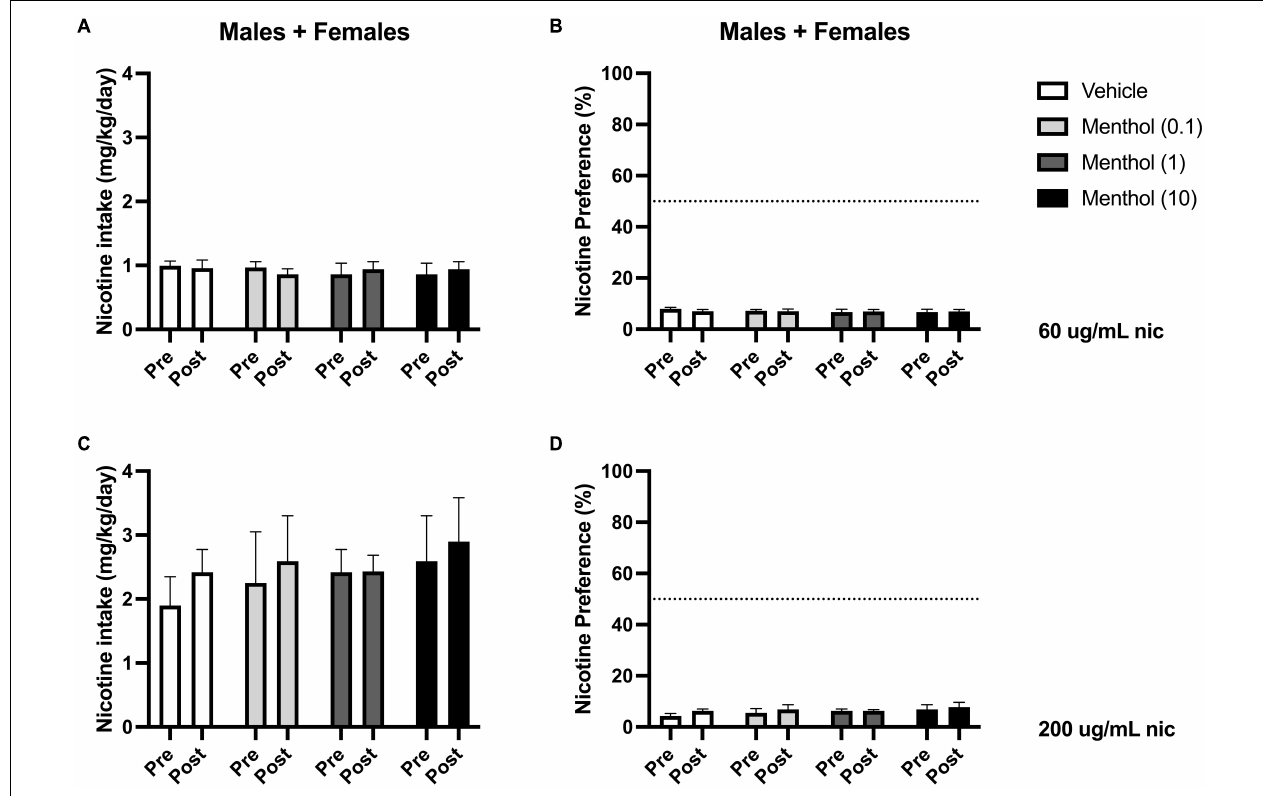
FIGURE 5 | Impact of systemic administration of menthol on oral nicotine consumption in adult DBA/2J mice. Male and female D2J mice were given a choice of DI water or nicotine solution [60 or 200 µ g/mL] for 7 days. On days 1–5, mice were poked daily to simulate i.p. injections. On day 6 (PRE), mice received an acute injection of vehicle (1:1:18) or menthol (0.1, 1, and 10 mg/kg). Nicotine intake and preference were then measured 24 h. after injection on day 7 (POST). (A,C) Nicotine intake and (B,D) preference 24 h. after drug administration was calculated. Data are presented as the mean ± SEM of 10–20 mice/group.